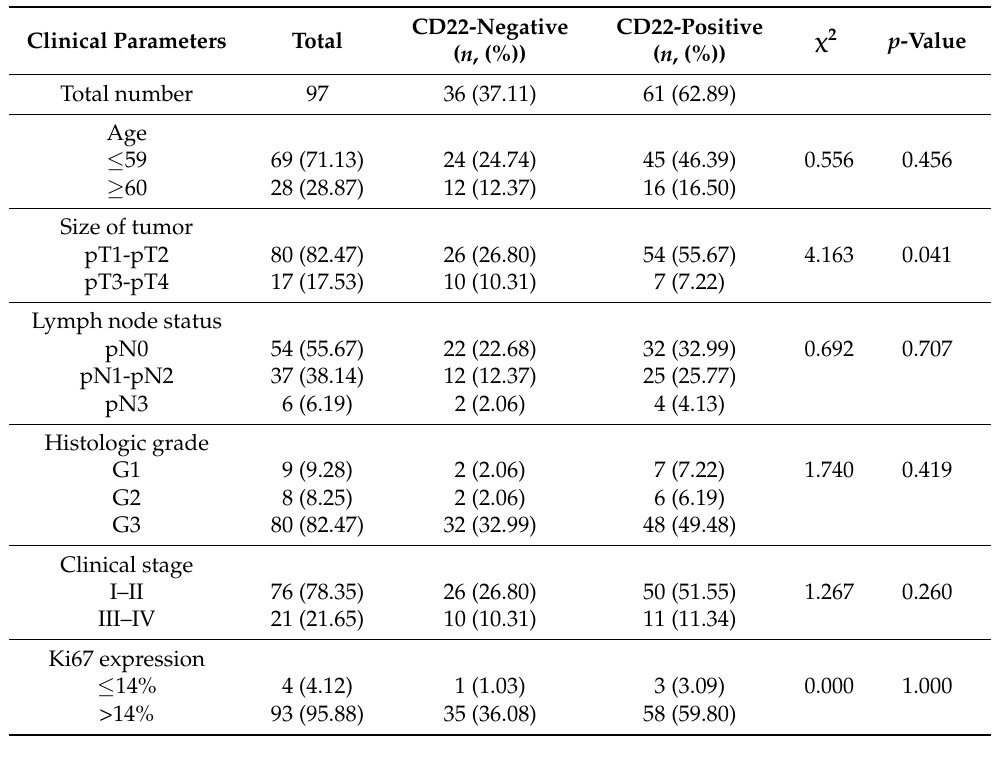
Table 3. Analysis of the relationship between CD22 expression level and clinical pathological parameters in triple-negative breast cancer tissues ( n = 97).